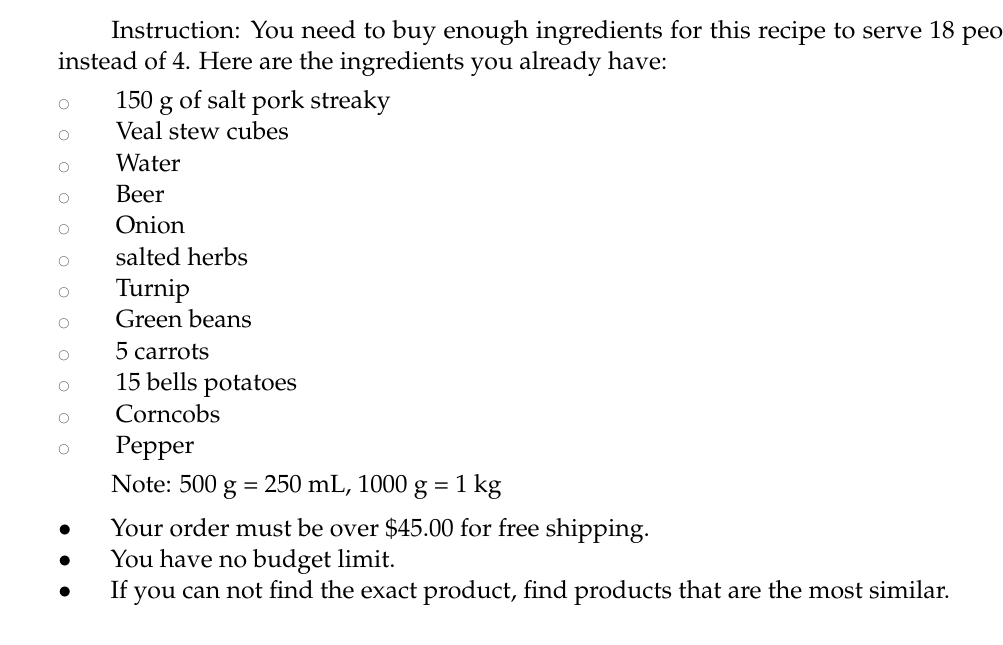
Figure A4. Recipe used for the condition with high arithmetic complexity and experience